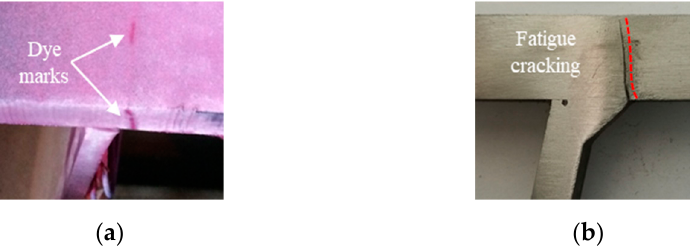
Figure 2. Typical cracking pattern: ( a ) Crack identified by DP checks; ( b ) Marco-section of the cracked joint.